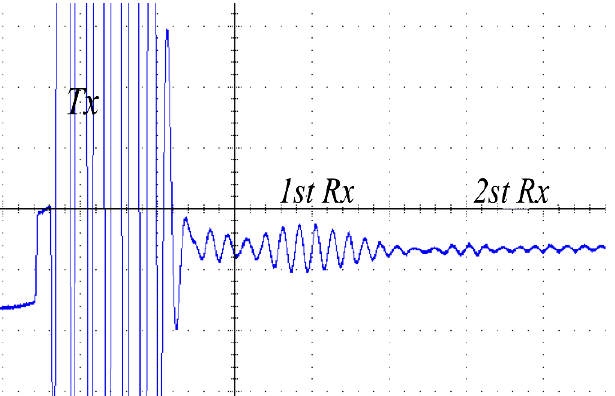
Figure 17. Experimental results of the receiving ultrasonic waveforms of the Class-D resonant converter (400 nS/div 500 mV/div Rx VPP = 360 mV).